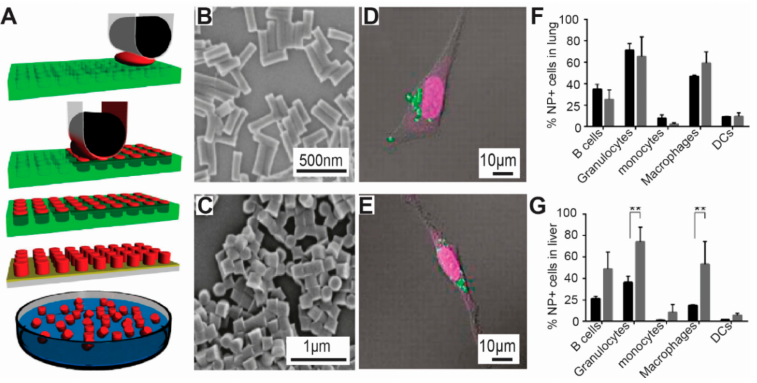
Figure 5. PRINT techniques were used to develop nanoparticles for delivering therapeutic cargos. ( A